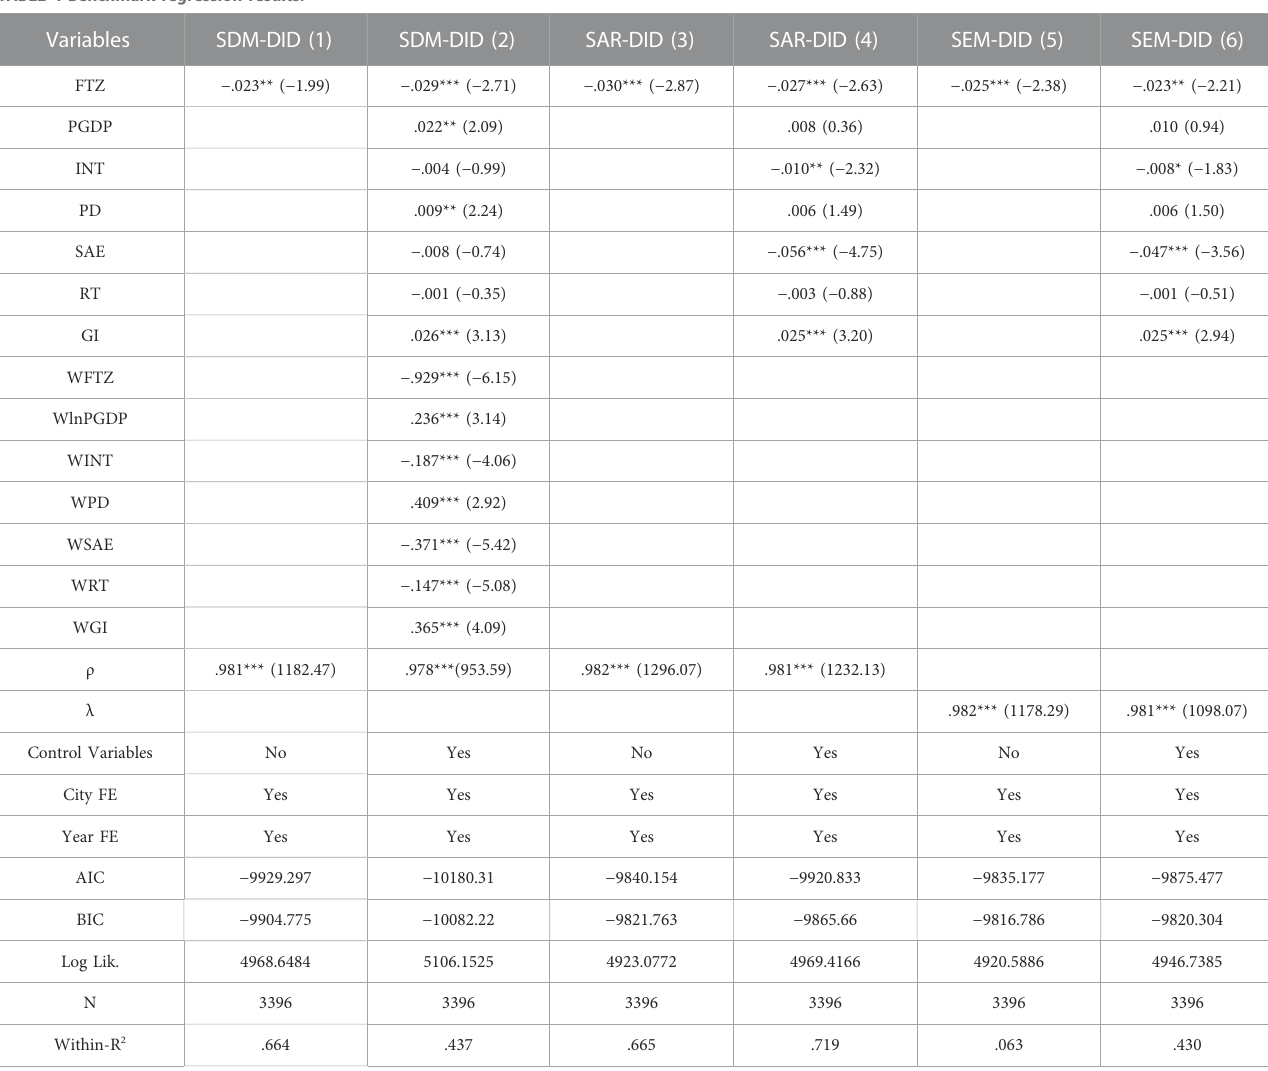
TABLE 4 Benchmark regression results.